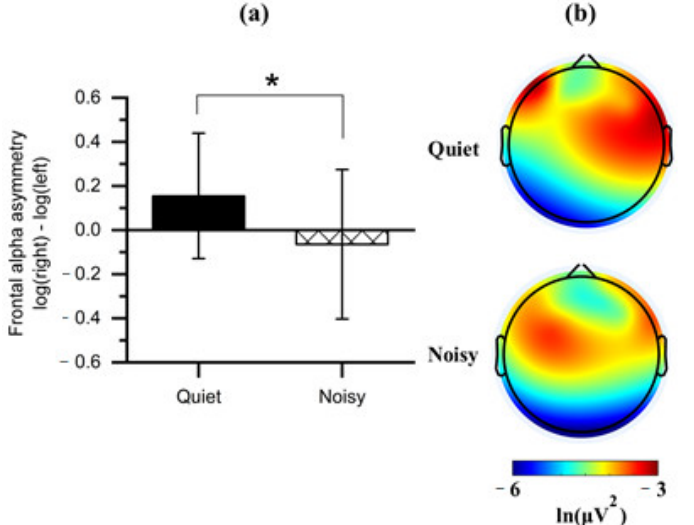
Figure 6. ( a ) Mean of frontal alpha asymmetry scores obtained during the quiet and noisy work- places. Error bars indicate the standard deviations; ( b ) Topographical maps of alpha power for each workplace. Note: the alpha power is inversely associated with cortical activation. The asterisk (*) indicates p < 0.05.